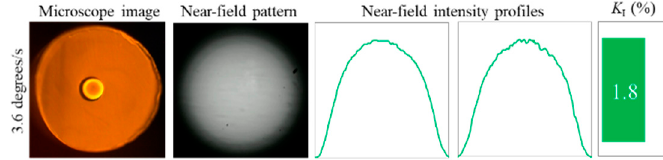
Figure 10. Cleave performed at temperature ≈ 90 °C and rotation speed of 3.6 degrees/s (2 s per cleave) using the Wilkinson RB.